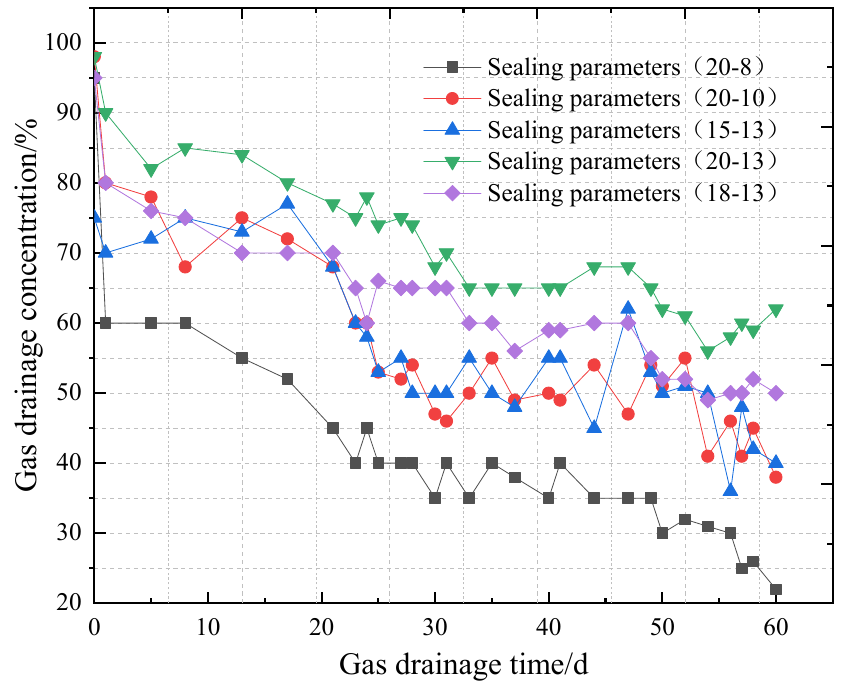
Figure 11. Average volume fraction of gas extraction from boreholes.